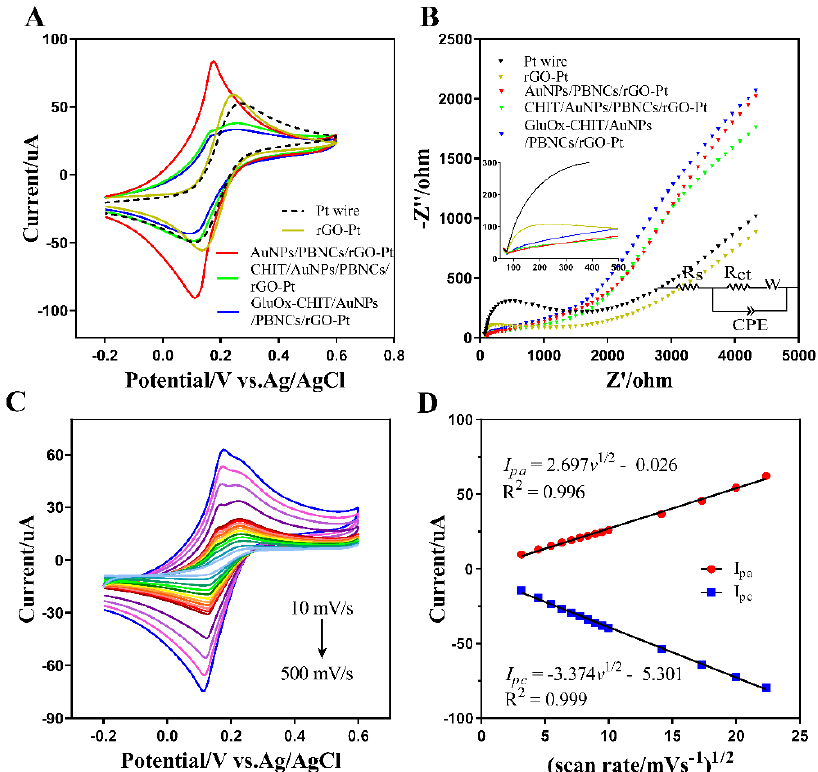
Figure 4. Electrochemical activities of the modified electrode. ( A ) Cyclic voltammetry (CV) responses and ( B ) Nyquist plots of Pt wire, rGO-Pt, AuNPs/PBNCs/rGO-Pt, CHIT/AuNPs/PBNCs/rGO-Pt, and GluOx-CHIT/AuNPs/PBNCs/rGO-Pt in the K 4 [Fe(CN) 6 ]/K 3 [Fe(CN) 6 ] system; ( C ) CV responses of the modified electrode for different scan rates from 10–500 mV/s; ( D ) linear plot for characteristic peak current intensities versus the square roots of the scan rates.